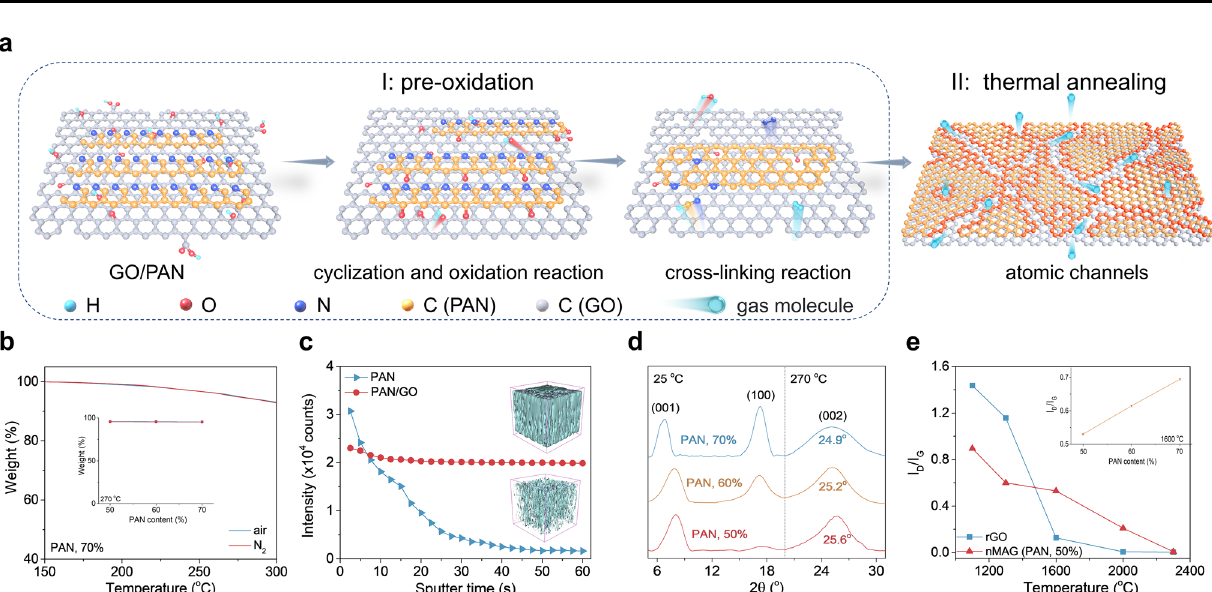
Fig. 2 PAN-derived atomic-scale gas escape channels. a Schematic diagram of the formation of atomic channels in GO/PAN. b TGA plot of GO/PAN (PAN, 70%) in N 2 and air atmosphere; inset shows the residual masses for nMAGs with different PAN contents heated to 270 °C in N 2 and air. c ToF–SIMS elemental depth profiles for oxygen element in 600-nm-thick pre-oxidized GO/PAN film (PAN, 70%) and PAN film, and their corresponding 3D mapping images of oxygen (inset). d X-ray diffraction patterns of GO/PAN films with different PAN contents before and after pre-oxidation at 270 °C. e I D / I G values of nMAG (PAN, 50%) and rGO heat treated at different temperatures. The inset shows I D / I G values of 1,600 °C-treated nMAGs assembled with varying contents of